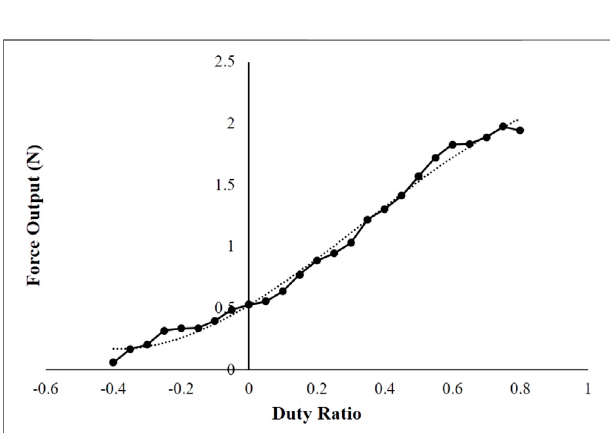
FIGURE 10 | Relationship between the duty ratio of PWM control and force output of the motor.